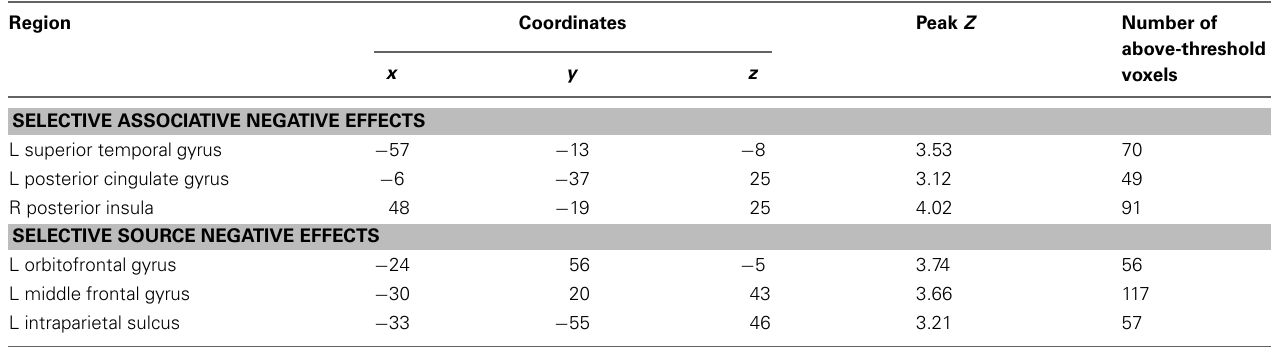
Table 3 | Loci of selective negative subsequent memory effects identified in subsidiary analyses.